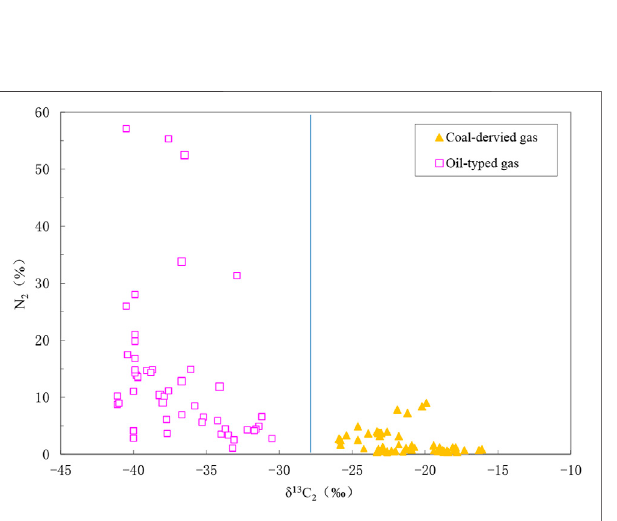
Frontiers in Earth Science |